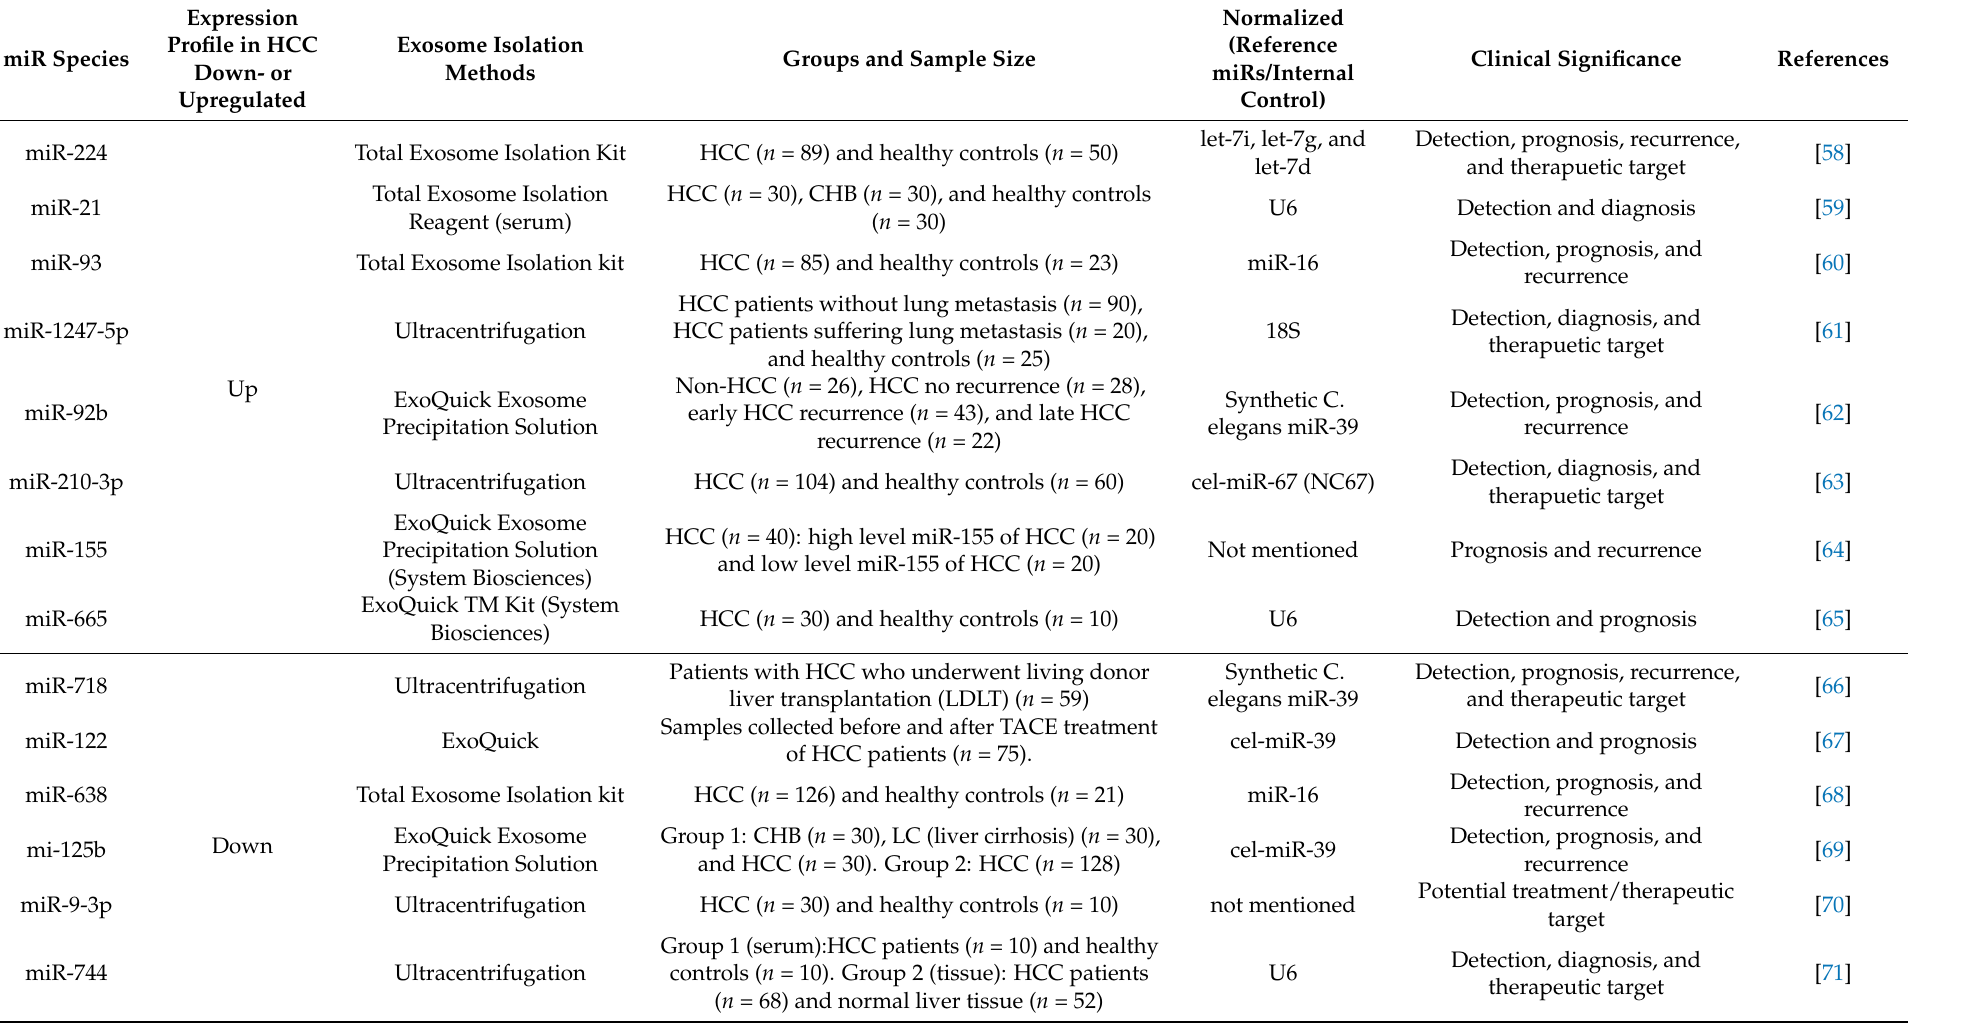
Table 1. Exosomal miRNAs with clinical significance in